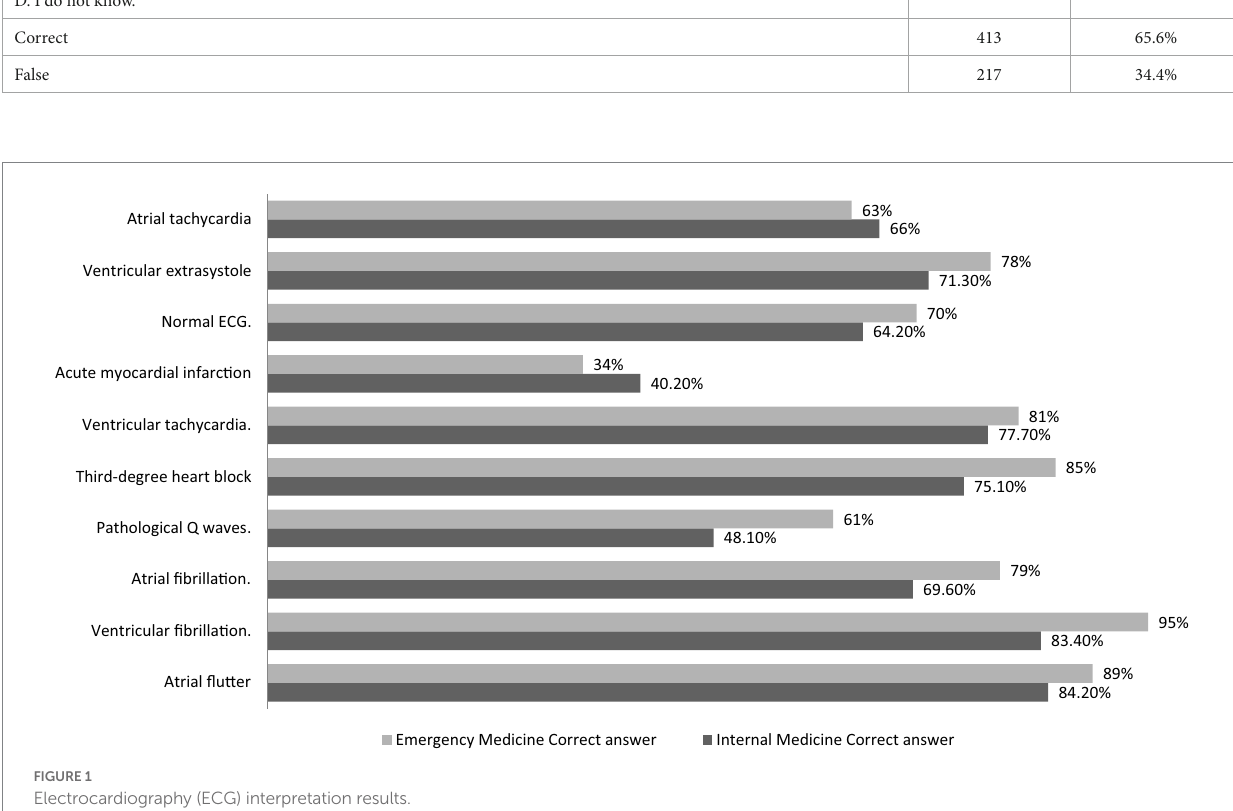
FIGURE 1 Electrocardiography (ECG) interpretation